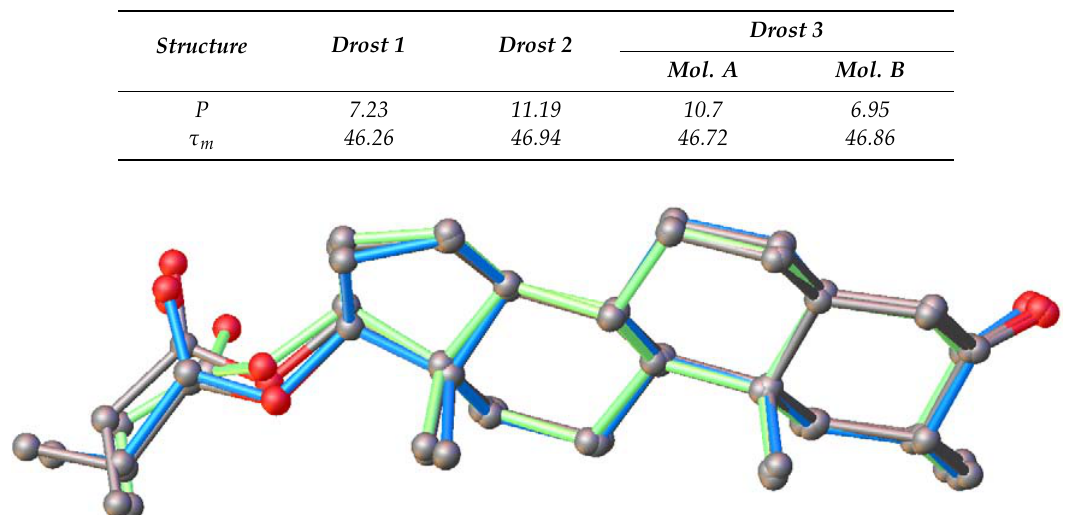
Figure 11. The overlay of the four molecular configurations: Drost 1 ‐ green, Drost 2 ‐ blue, and Drost 3 (A and B) ‐ gray.